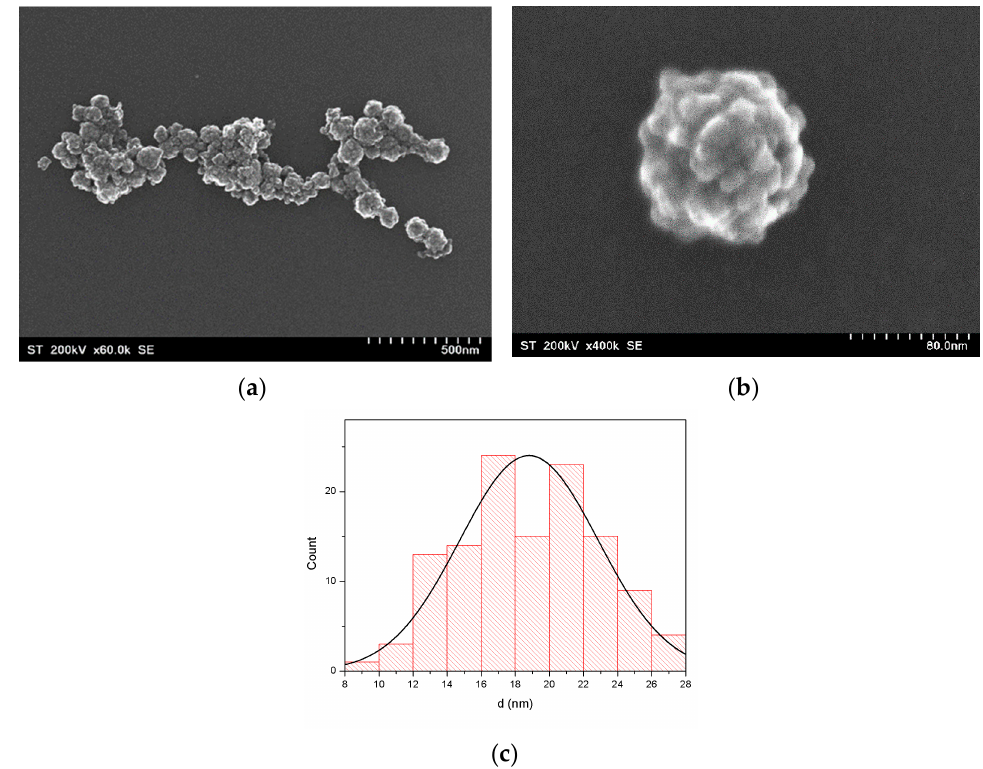
Figure 2. SEM images of CoFe 2 O 4 nanoparticles ( a , b ) and particle size histogram ( c ). After the deposition of SiO 2 , the TEM images show the formation of a shell layer (Figure 3). The nanocomposites thus formed had spherical or pseudo-spherical forms. A similar morphology was shown after gold deposition (Figure 4). CoFe 2 O 4 @SiO 2 @AuN nanoparticles were nearly completely covered by gold. High